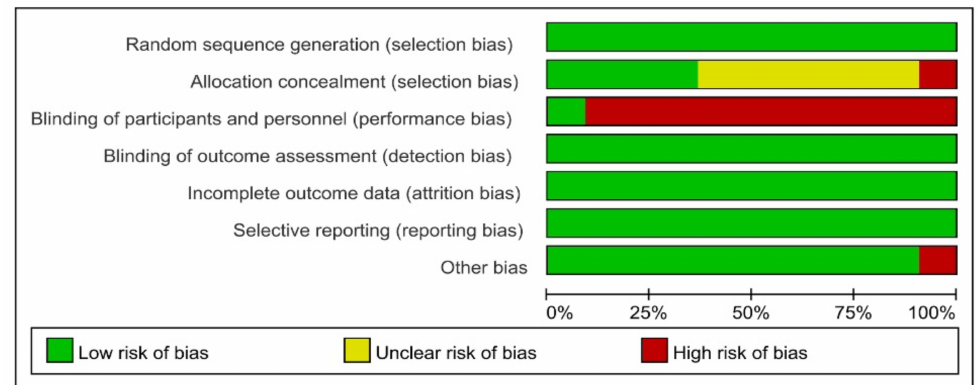
Figure 3. Quality evaluation results of included studies’ risk of bias (ROB). ROB levels: low (green), unclear (yellow), and high